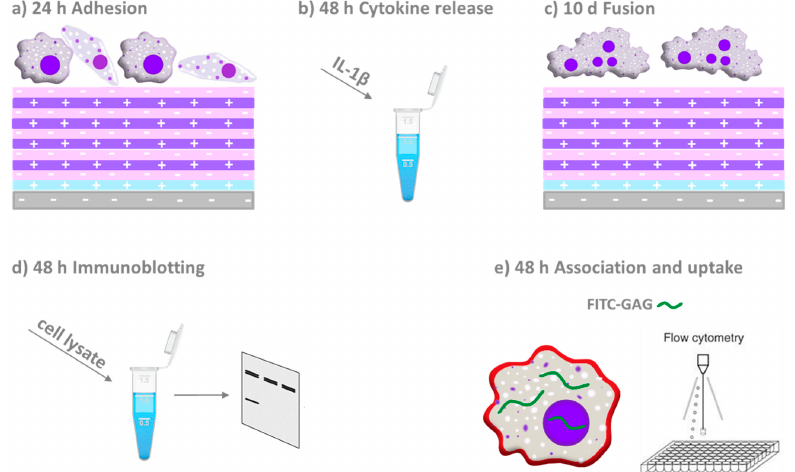
Figure 1. Schematic overview on the material system and design of the biological studies. Polyelectrolyte multilayers were assembled on model substrata glass or silicone (grey base layer with negative charge) on which a priming layer of poly (ethylene imine; blue layer with positive charge) was adsorbed first. Then alternatingly the polyanions heparin or hyaluronan (pink layer with negative charge) and chitosan as polycation (purple layer with positive charge) were adsorbed until 10 layers in total were assembled. Macrophages derived from the THP-1 monocytic cell line were seeded on these multilayers to study ( a ) adhesion and spreading of cells after 24 h, ( b ) evaluation of the pro-inflammatory (IL-1 β ) cytokine release, ( c ) multinucleated giant cells formation, ( d ) immunoblotting and confocal laser scanning microscopy (CLSM) to study the p65 subunit of NF- κ B and ( e ) association and uptake of fluorescein isothiocyanate (FITC)-labelled GAG through macrophages by CLSM and flow cytometry.